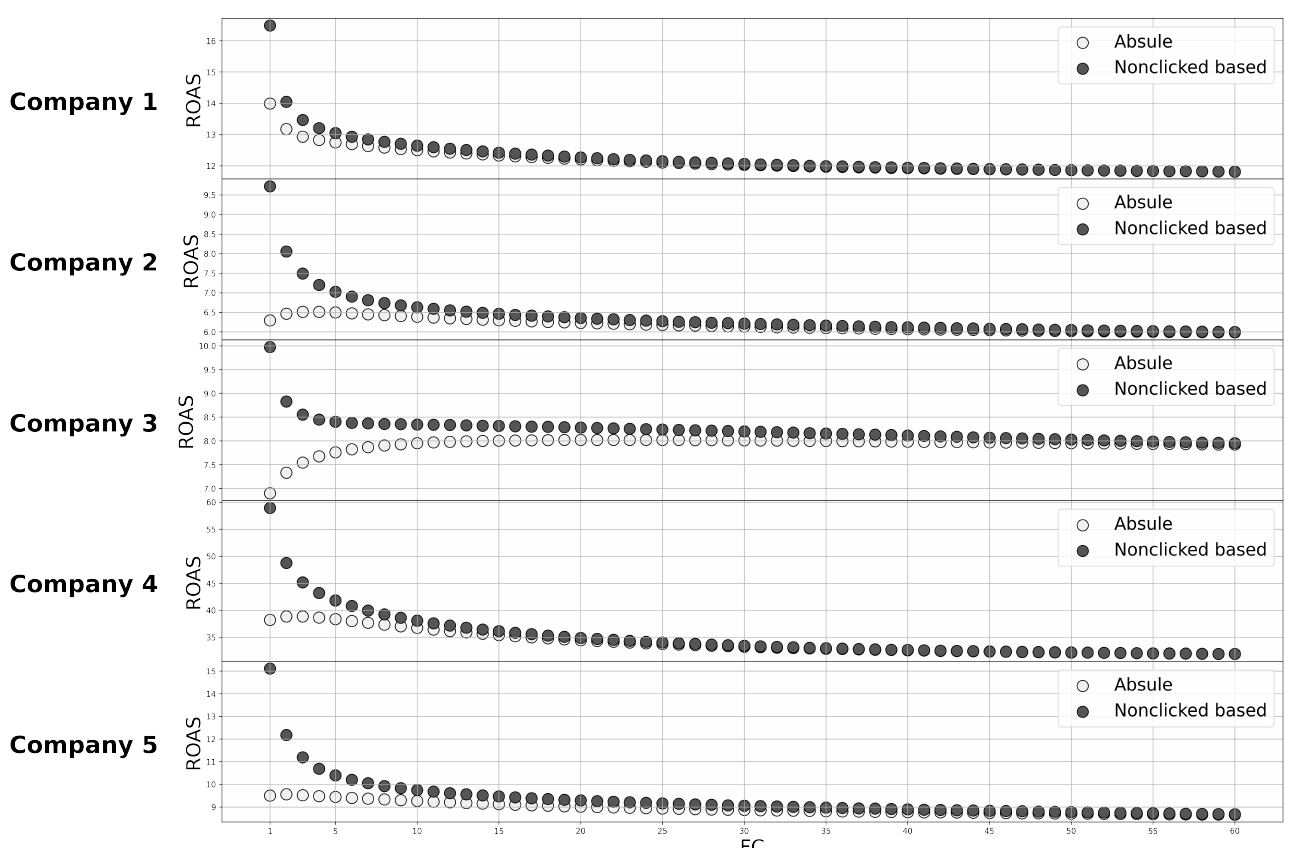
Figure 14. The figure shows us the ROAS after applying different FC on the historical data for each of the companies.